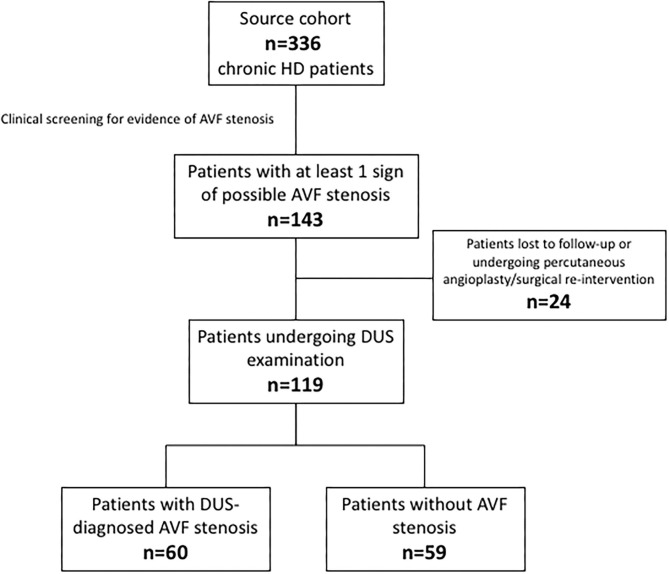
Patients' flow chart.